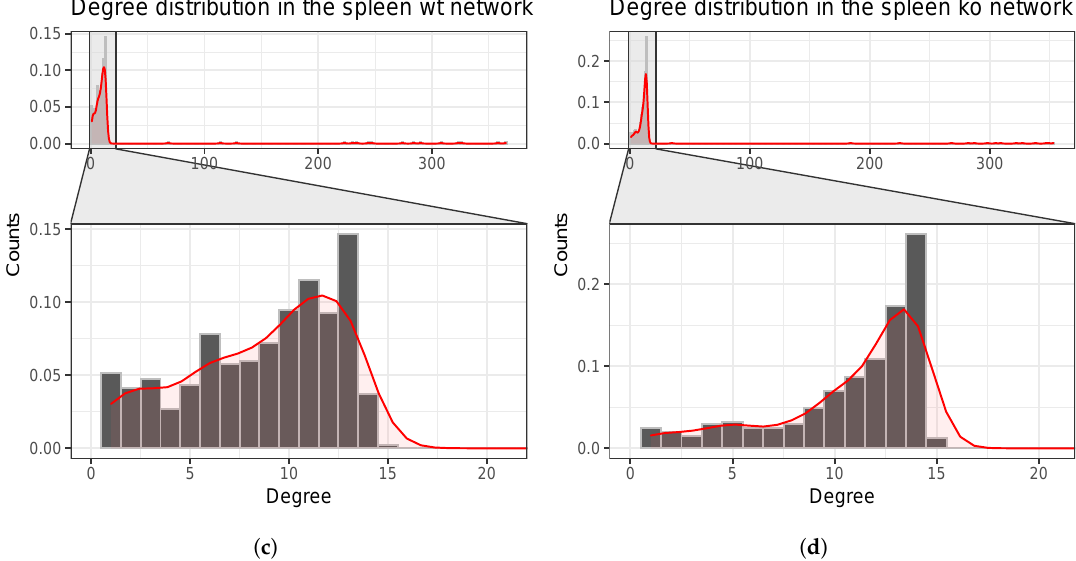
Figure A8. Distribution of node’s degree throughout the networks reconstructed from ( a ) liver wt samples, ( b ) liver ko samples, ( c ) spleen wt samples and ( d ) spleen ko samples. The distribution trendline is shown in red. Nodes that are not present in the zoomed area are considered hubs. Note degree